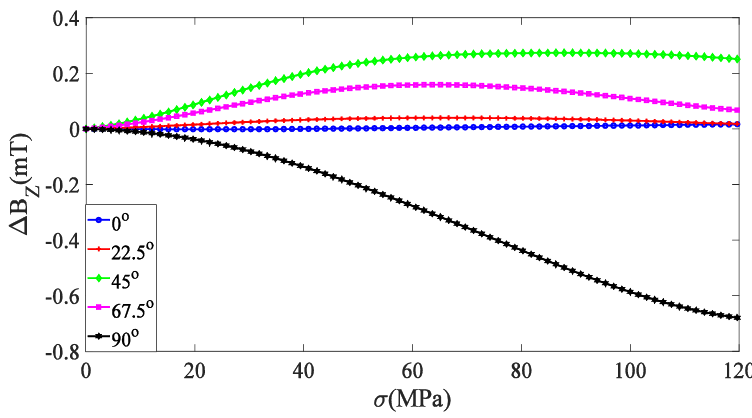
Figure 10. Variations in B Z relative to stress σ at angles of 0°, 22.5°, 45°, 67.5°, and